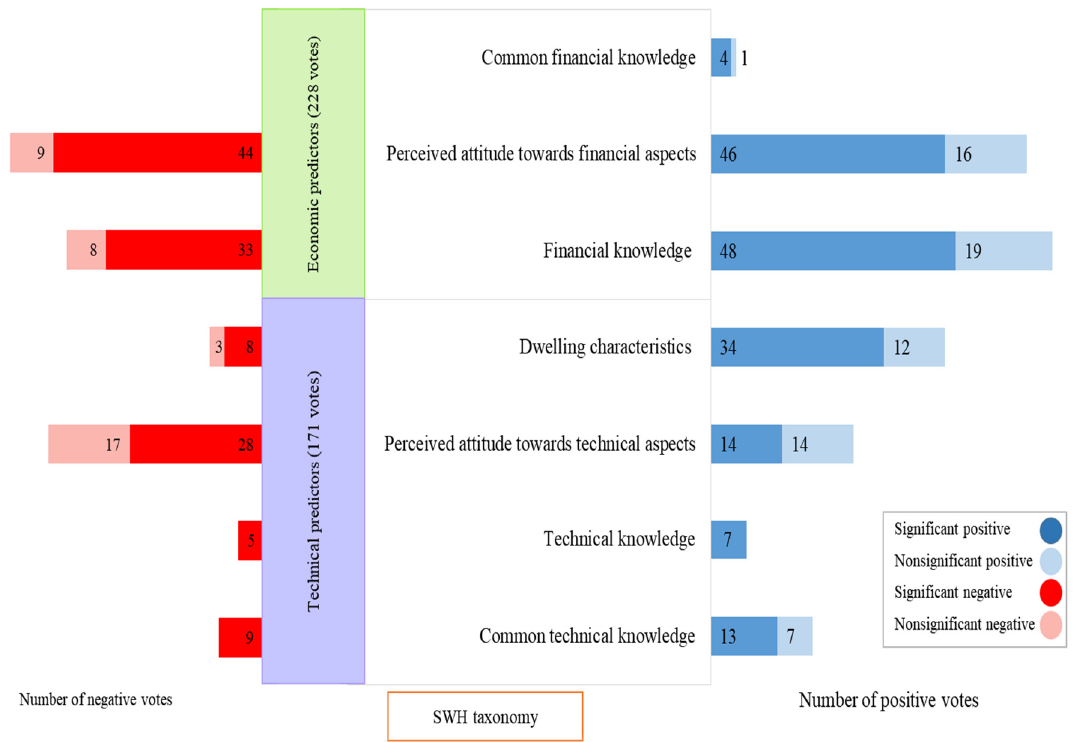
Figure 5. Overall vote-counting results of the main categories.